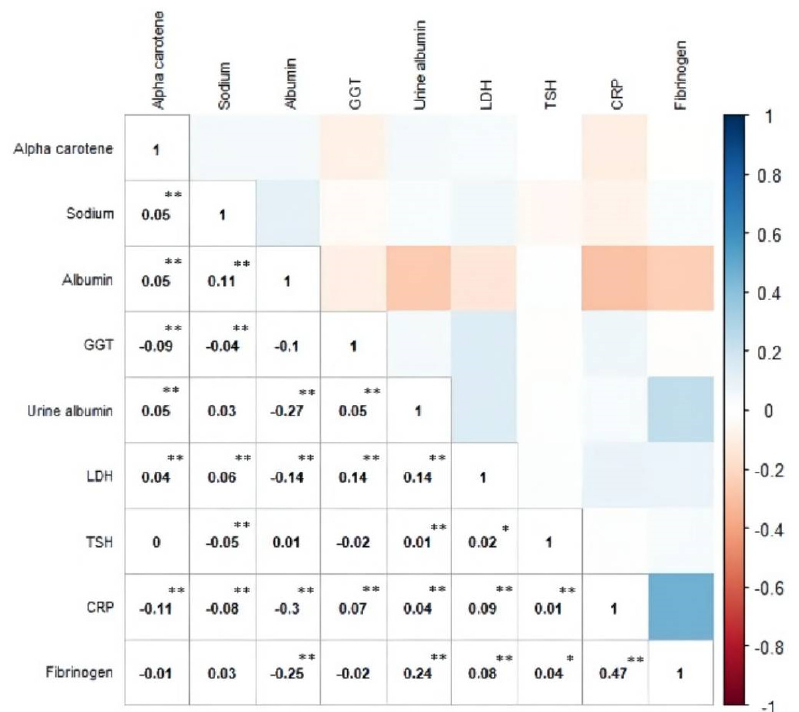
Figure 2. Spearman correlation between significant biomarkers based on Model 2. The figure is ordered by using hierarchical clustering. * denotes the p -value for test of correlation coefficient is <0.05; ** denotes the p -value is <0.01. TSH: Thyroid stimulating hormone; GGT: gamma glutamyl transferase; CRP: C-creative protein; LDH: lactate dehydrogenase. All biomarkers are from blood samples except urine